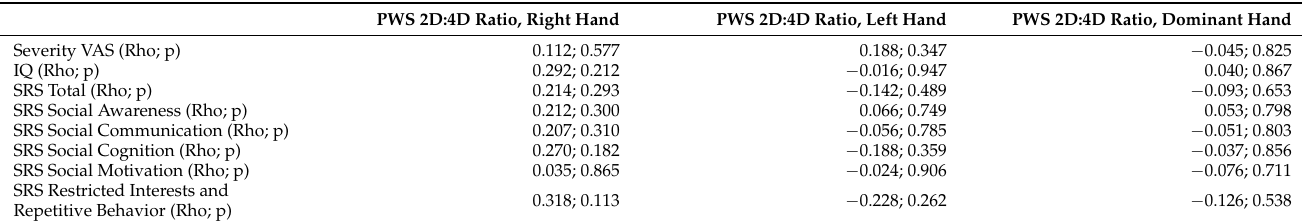
Table 2. Bivariate correlations in PWS participants (n=26) for 2D:4D ratios. PWS 2D:4D Ratio, Right